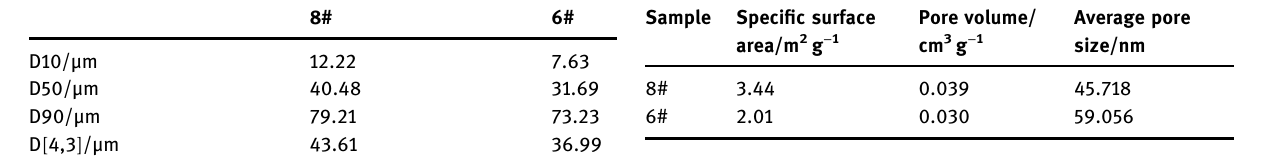
Table 6: BET analysis test results of products after pickling Sample Speci fi c